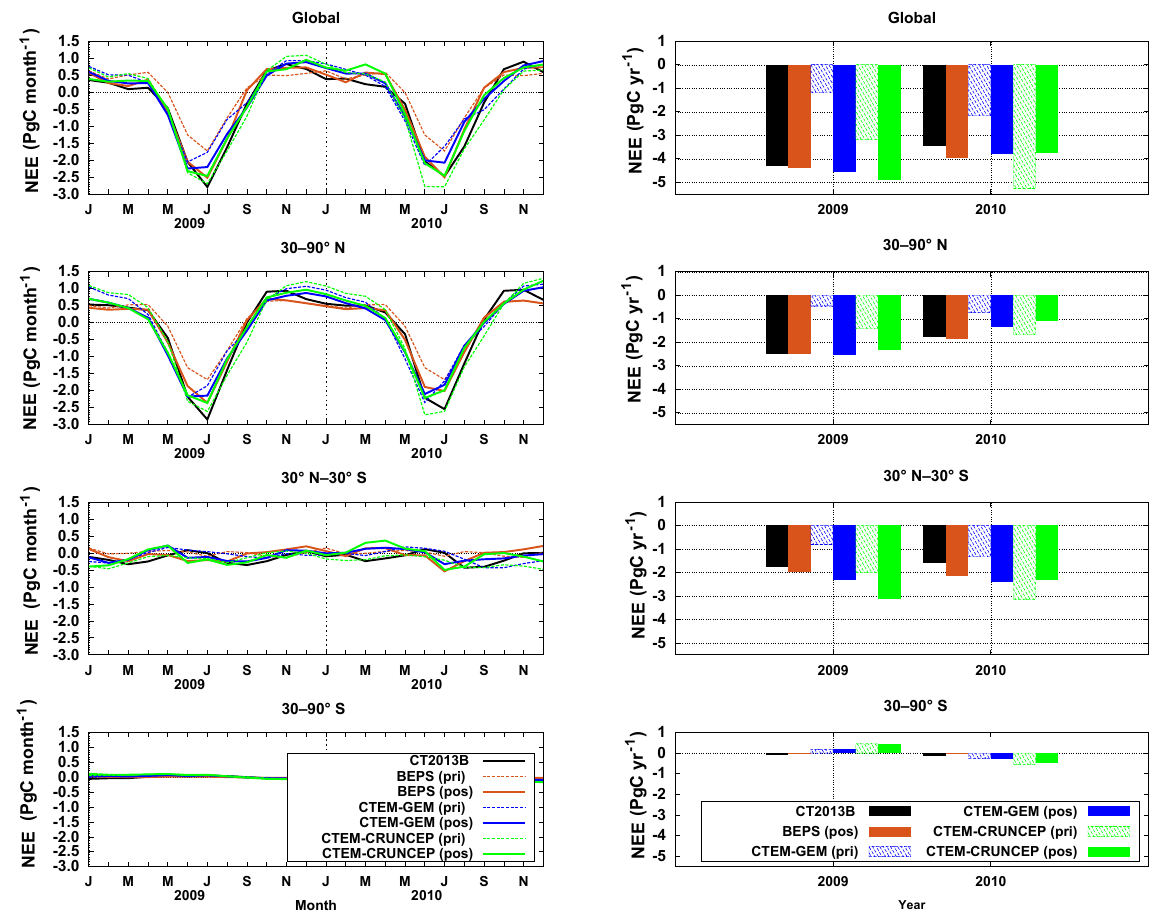
Figure 14. The monthly (left) and annual total (right) of the optimized NEE from GEOS-Chem using three different prior flux estimates of NEE from CTEM-GEM, CTEM-CRUNCEP, and BEPS (indicated as well) in comparison to the optimized NEE from CT2013B integrated over three latitudinal